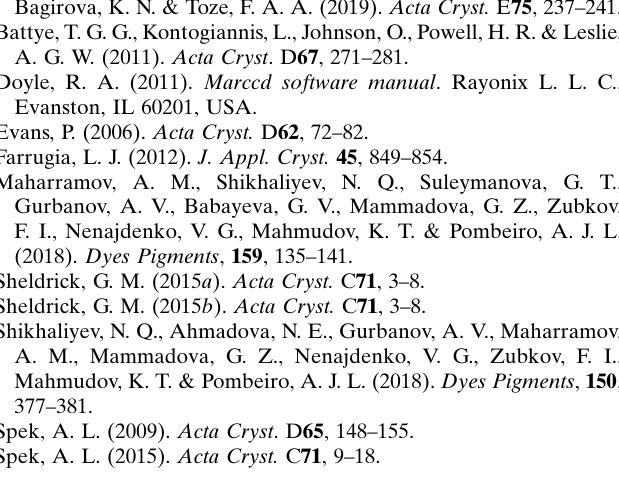
group are disordered over 3